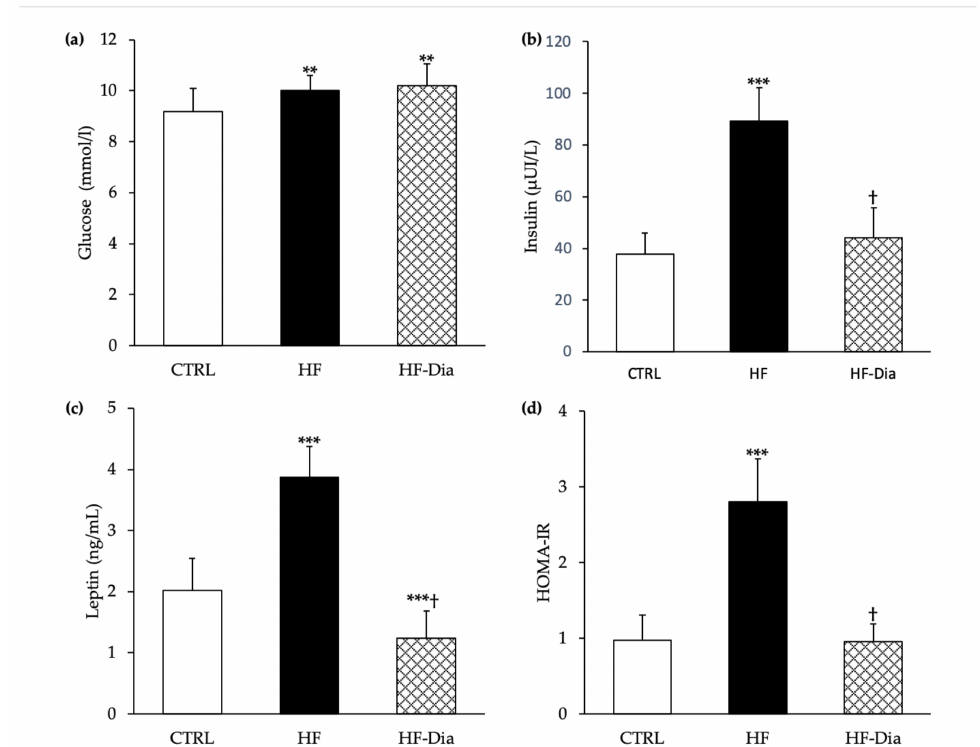
Figure 3. Effects of D. lutheri supplementation on plasma glucose ( a ), insulin ( b ) and leptin ( c ) levels and HOMA-IR index ( d ). CTRL, control group; HF, high-fat group; HF-Dia, high-fat group sup- plemented with D. lutheri ; TAG, triacylglycerol; TC, total cholesterol. Values are means (n = 6), with standard deviations represented by vertical bars. Statistical significance was determined using ANOVA with post hoc Fisher’s test and mean values were significantly different from those of the CTRL group with ** p < 0.01 or *** p < 0.001. † Significant difference compared with the HF group ( p <